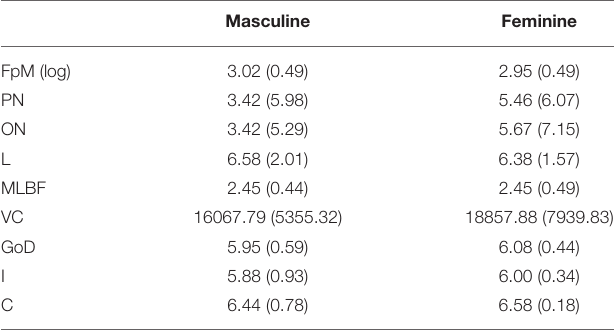
TABLE 5 | Mean and standard deviations (in parenthesis) of the controlled variables across targets’ gender values for all the experimental pictures in Experiment 2.